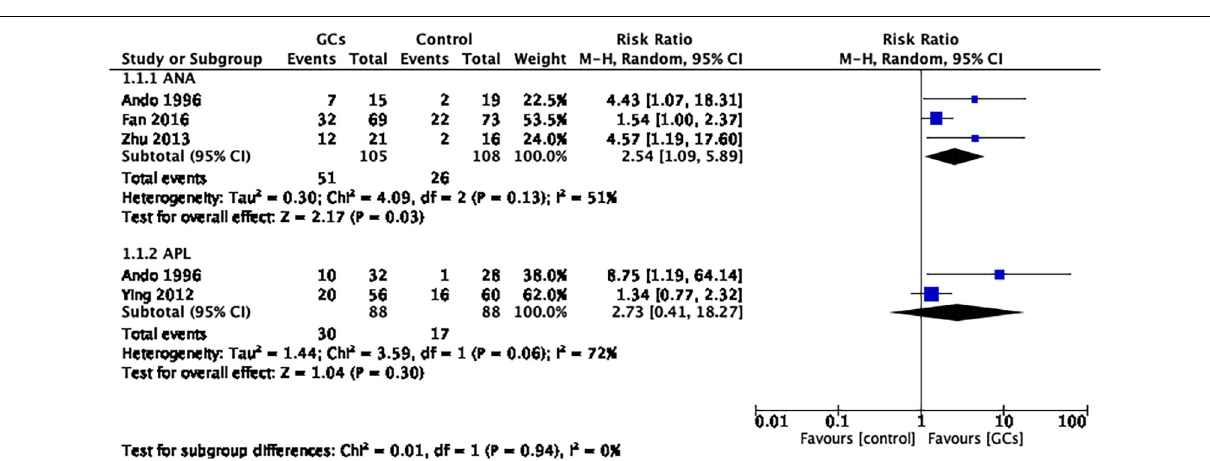
FIGURE 3 | Forrest plot comparison: glucocorticoids versus no glucocorticoids/placebo, outcome: I. II Clinical pregnancy rate per couple in subgroups by autoantibody. The ANA-positive subgroup favored glucocorticoid therapy, while the APL-positive subgroup did not (ANA: RR 2.54, 95% CI 1.09 –5.89, p = 0.03, three cohort studies, 213 women, I 2 = 51%; APL: RR 2.73, 95% CI 0.41–18.27, p = 0.30, two cohort studies, 176 women, I 2 =